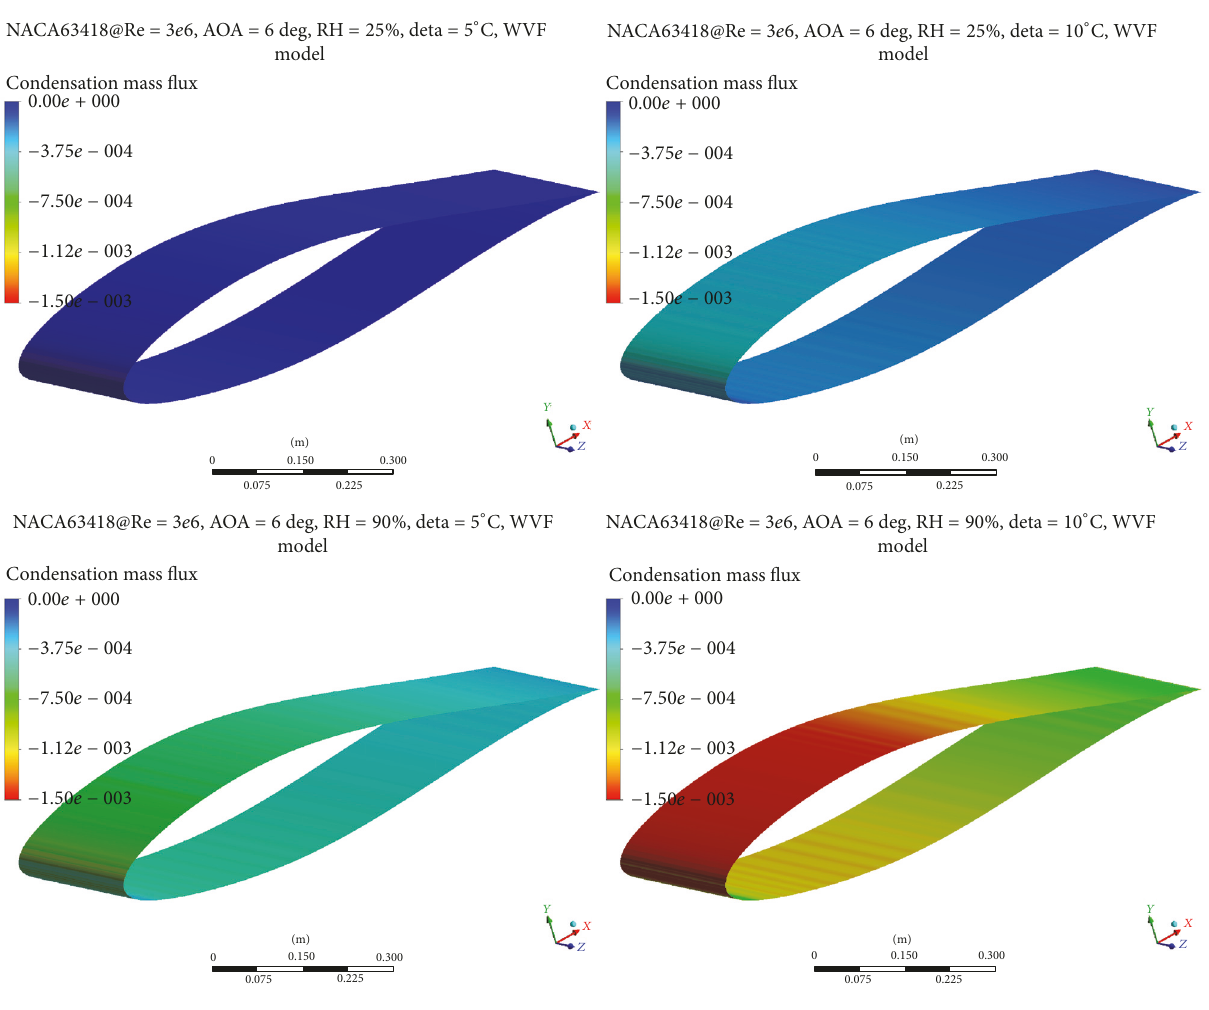
Figure 8: Contour plots of condensation mass flux on airfoil using 3D VF